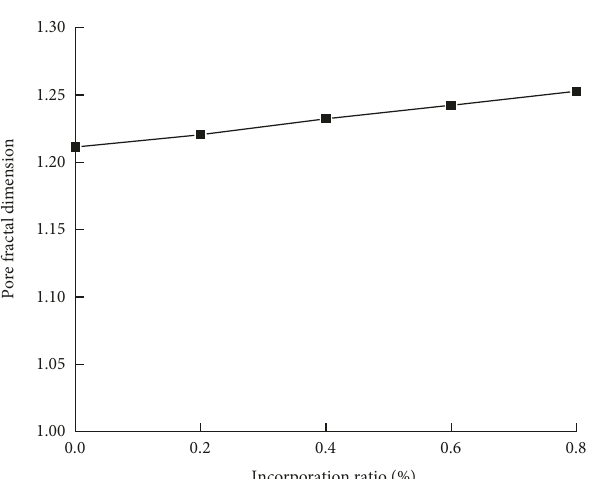
Figure 16: Pore orientation probability entropy versus fiber ratio.